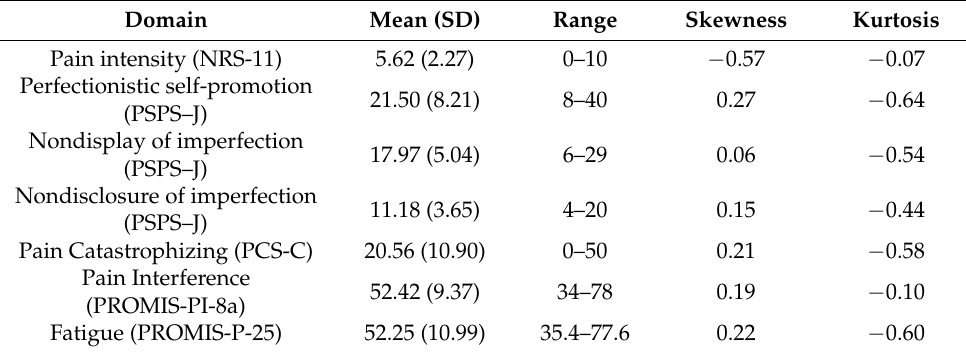
Table 2. Descriptive statistics for the study